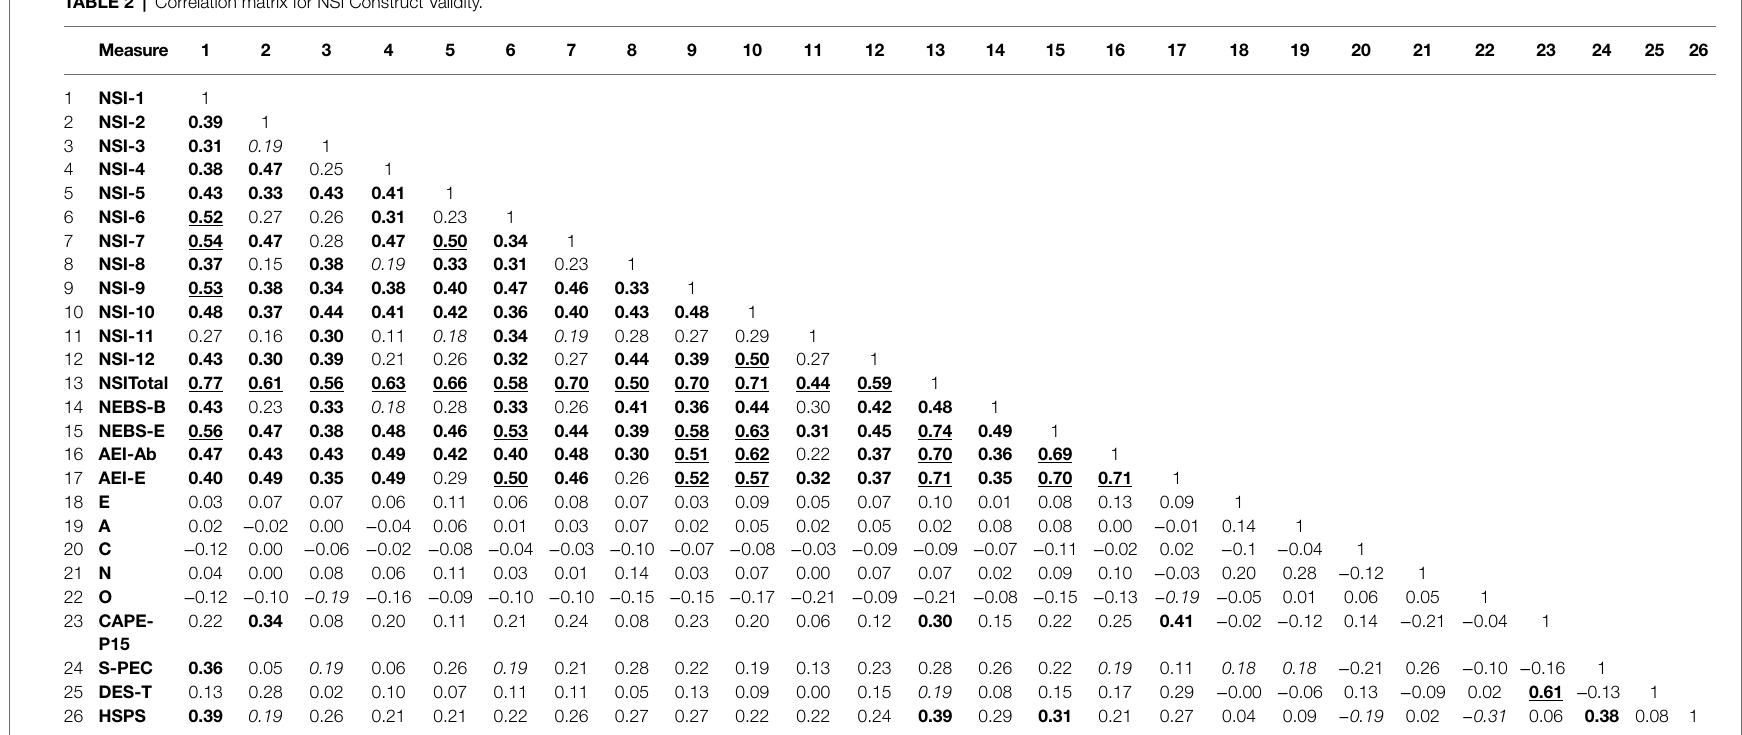
TABLE 2 | Correlation matrix for NSI Construct